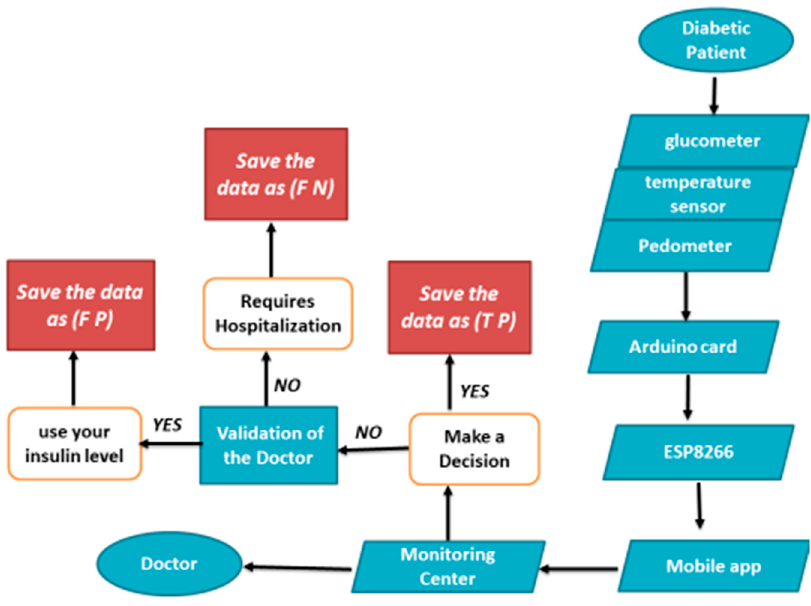
Figure 4. Flowchart of the system.